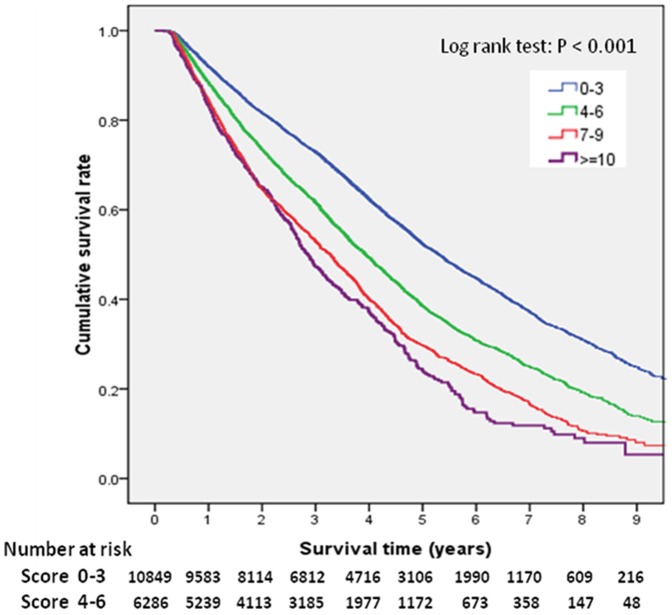
Survival curves for elderly patient groups with comorbidity scores(≤3, 4–6, 7–9, and ≥10).Further analysis of only the third (7–9) and fourth (≥10) groups was performed, and a significant difference was found (log-rank: P = 0.017).